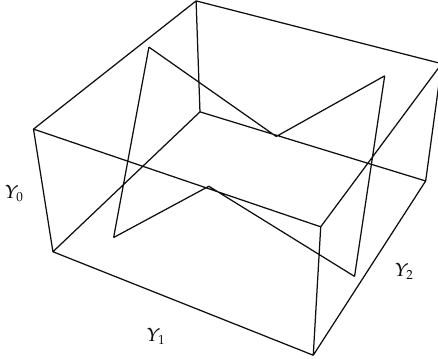
Figure 3: Polygon of light-like segments corresponding to the momenta of six external particles undergoing a